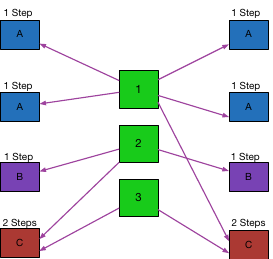
Figure 10. Schematic diagram of the relationship between the linear properties and power system problems in the proposed technique.